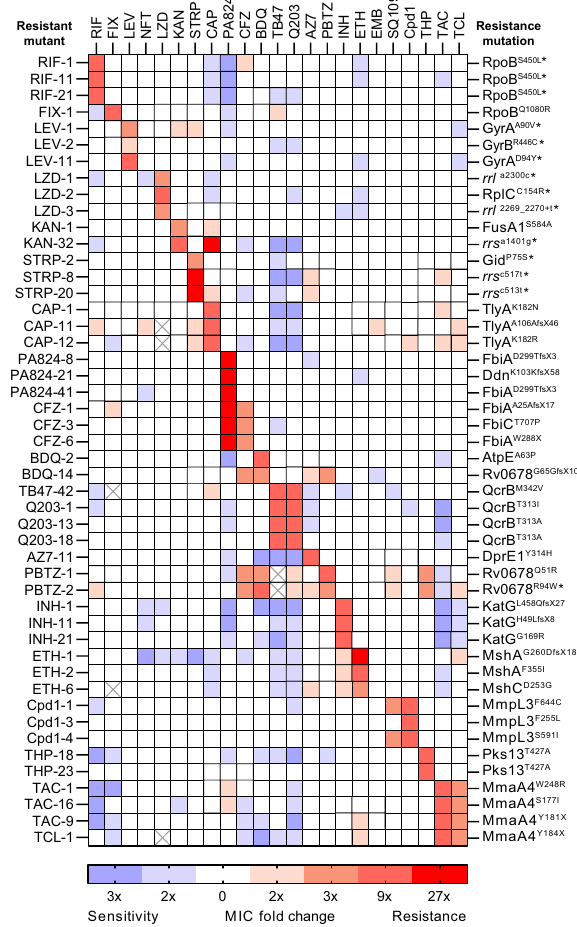
Fig.1|Collateralphenotypesassociatedwithdrugresistancein M.tuberculosis . Heatmaprepresentstherelationshipsof collateralphenotypes(i.e.bothresistance andsensitization)asdeterminedbychangesinminimuminhibitoryconcentrations (MIC) for 48 antibiotic-resistant variants evolved against 23 antibiotics. Colour coding represents the average fold increase (red) or decrease (blue) in MIC value for each resistant variant relative to the drug-susceptible parent. For each strain and antibiotic combination, a minimum of four independent experiments com- paring the MIC of eachdrug-resistant strainrelative to the drug-susceptibleparent were used. Strain names are on the left and antibiotics used in drug-susceptibility pro fi ling are along the top. Resistance mutations hypothesized as being respon- sible for the primary drug resistance are listed on the right and classi fi ed as pre- viously de fi ned 85 . Brie fl y, an ‘ X ’ in place of an amino acid after the codon position indicatesastopcodon.A ‘ fsX ’ indicatesaframeshiftresultinginastopcodonatthe de fi ned number of amino acids into the new reading frame. ‘ + ’ indicates a nucleotide insertion at speci fi ed location. Asterisks (*) represent mutations which have been observed in clinical isolates. Crossed out cells represent no data,due to antibiotic availability issues. RIF=rifampicin, FIX= fi daxomicin, LEV=levo fl oxacin, LZD=linezolid, KAN=kanamycin, STRP=streptomycin, CAP=capreomycin, PA824=pretomanid, CFZ=clofazimine, BDQ=bedaquiline, AZ7=AZ7371, PBTZ= PBTZ-169, INH=isoniazid, ETH=ethionamide, EMB=ethambutol, THP= thiophene-2, TAC=thioacetazone,